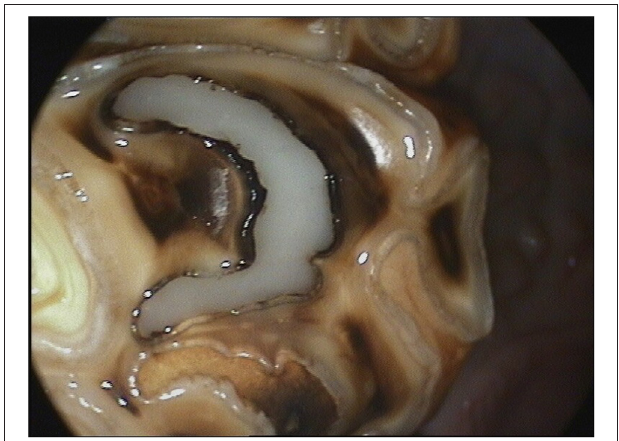
FIGURE 5 | Oroscopic image of the mesial infundibulum of a Triadan 109 tooth, 2 years post-restoration.